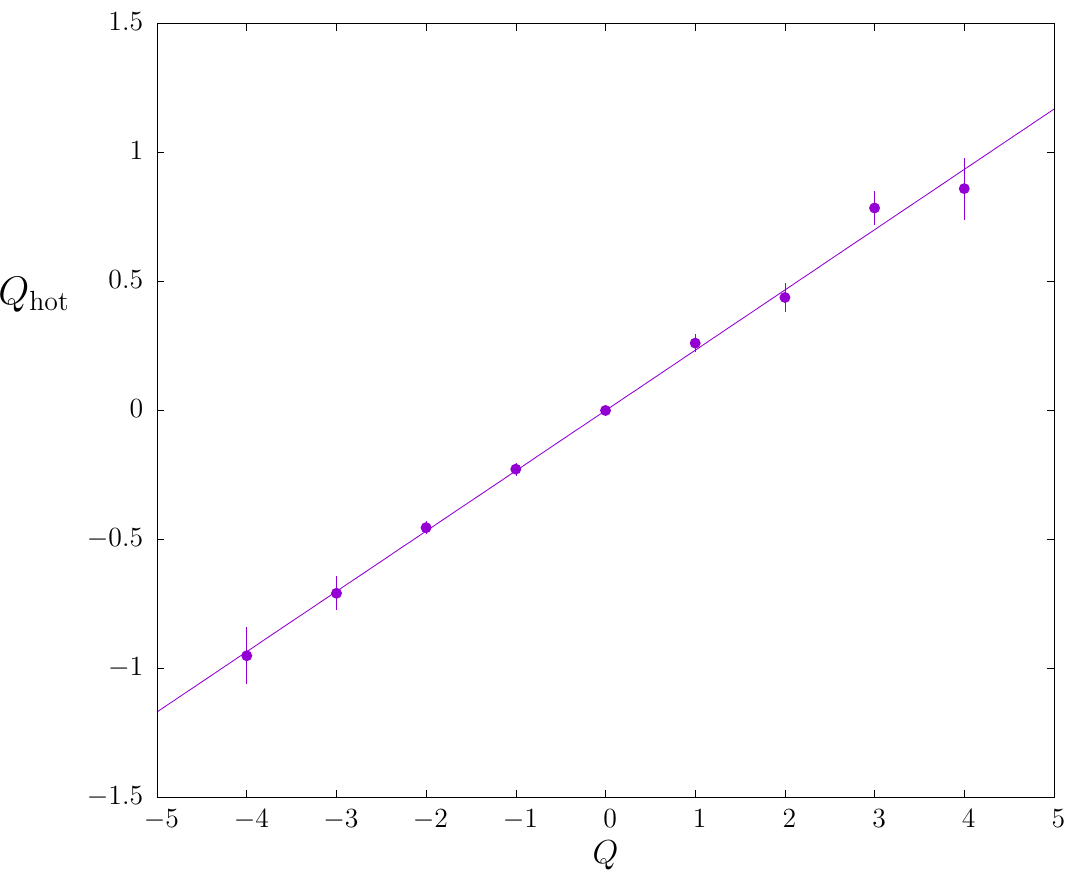
Figure 30 . Average topological charge on lattice fields which have an integer-valued charge Q after 20 cools; on 26 3 38 lattices at β = 6 . 5